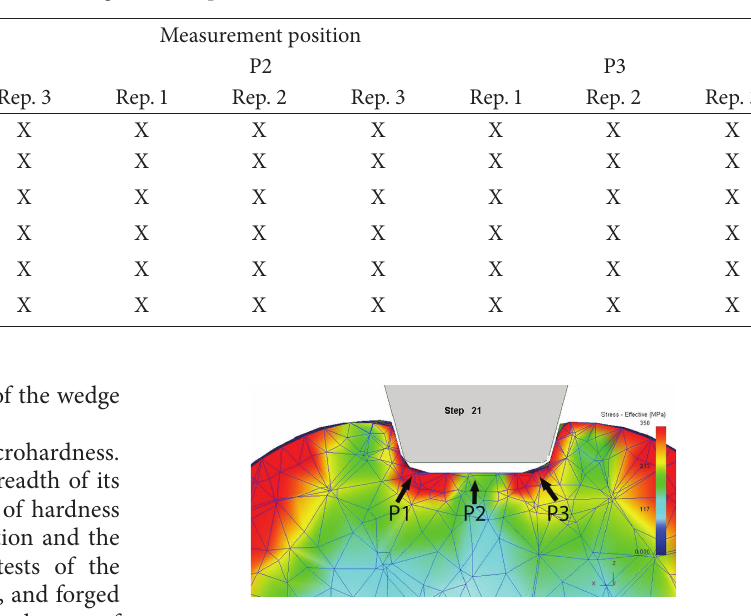
Figure 1: Numerical simulation showing von Mises equivalent